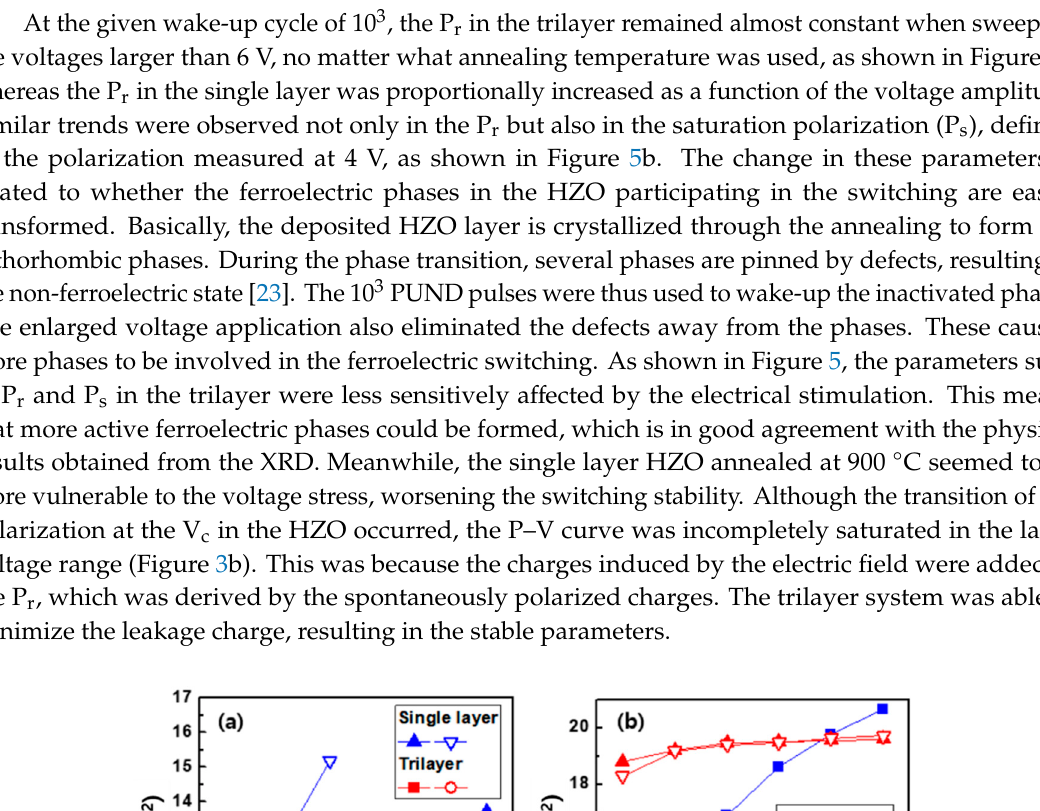
Figure 4. Highest peak intensity at 2 theta of around 30° was shown in the trilayer, whereas the peak was decreased in the single layer annealed at 900 °C.